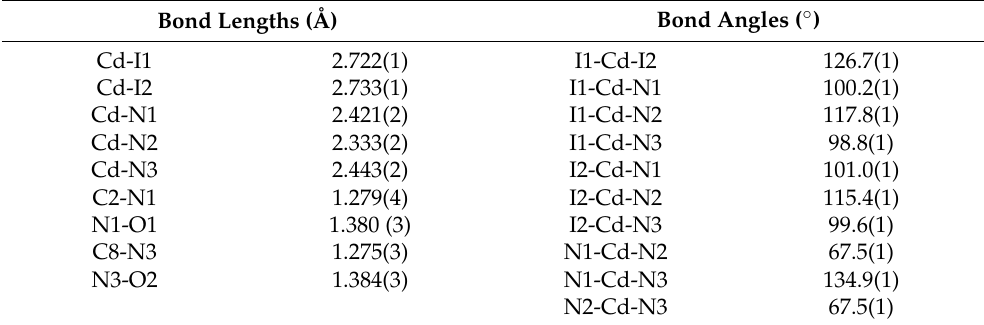
Table 5. Selected bond lengths (Å) and angles ( ◦ ) for complex [CdI 2 (dapdoH 2 )] · 2EtOH ( 4 · 2EtOH).